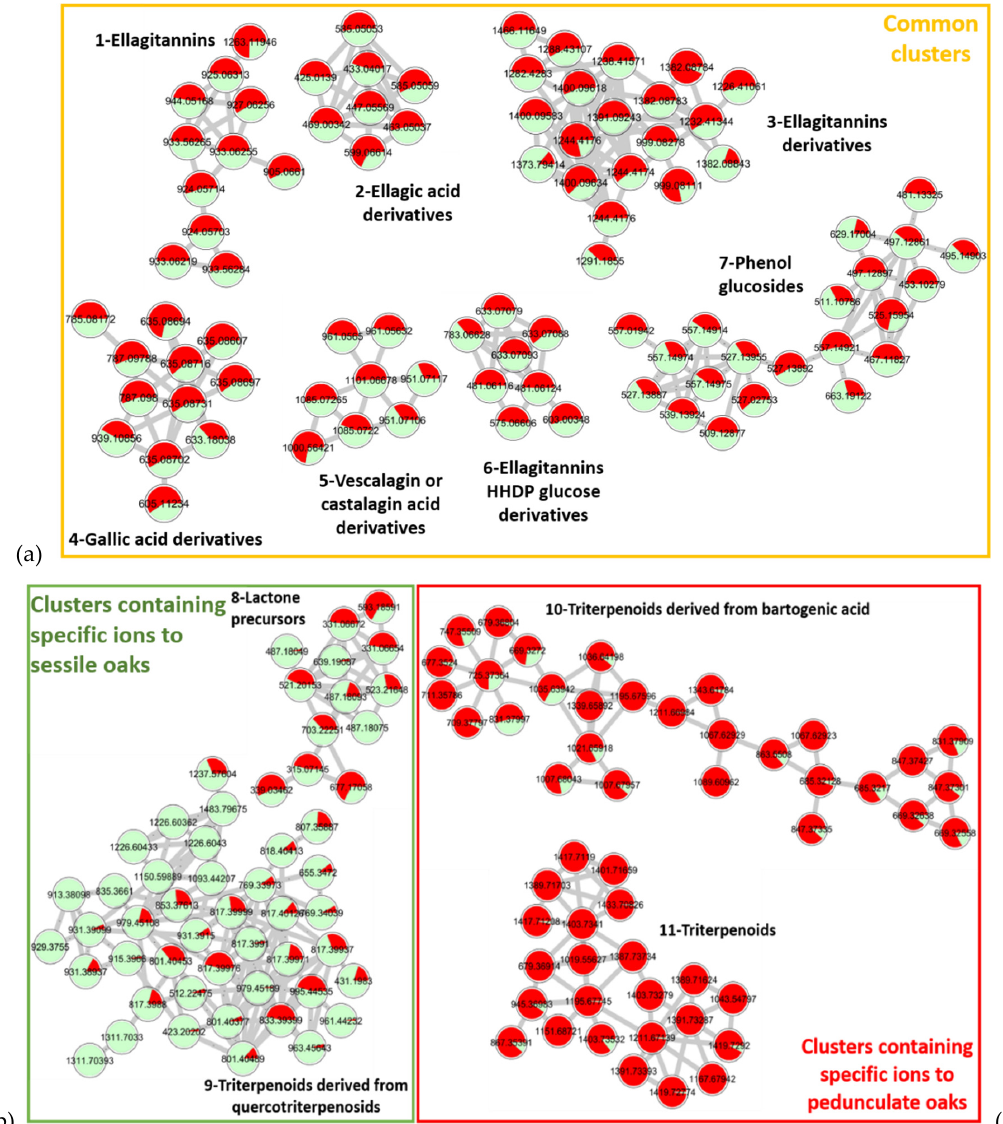
Figure 2. Mapping of pooled extracts (21 samples) of sessile (green) and (21 samples) pedunculate (red) oaks with cos 0.75 and matched fragment 6 parameters. ( a ) Clusters 1-7 representing common clusters between sessile and pedunculated oaks, ( b ) Clusters 8 and 9 containing specific ions to sessile oaks, ( c ) Clusters 10 and 11 containing specific ions to pedunculated oaks.